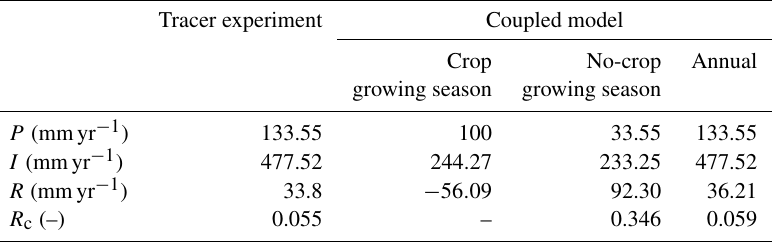
Table 6. The recharge sources and results of the tracer experiment.